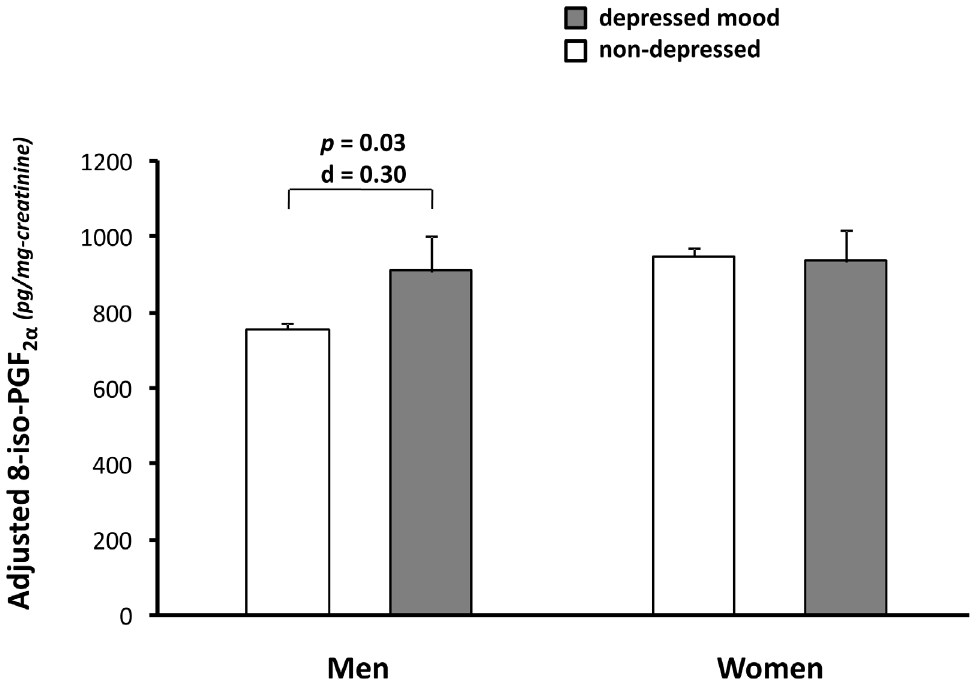
Figure 1. Adjusted means (and standard errors) of 8-iso-PGF 2 a according to depression group in men and women. Values were adjusted for age, race, education, site, alcohol use, smoking, 3MSE, physical activity, BMI, cerebrovascular disease, CVD and diabetes. Statistical significance from analyses based on log-transformed 8-iso-PGF 2 a due to skewed distribution.